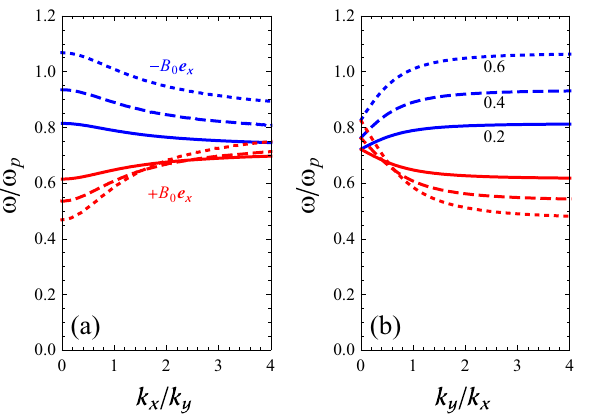
Figure 6. Dispersion curve of SMPs at a flat magnetized electron gas-vacuum interface, as obtained from Eq. (9), when ( a ) k y is positive constant and ( b ) k x is positive constant. Here the different curves correspond to ω c 0.2 ω p (solid lines), ω c 0.4 ω p (dashed lines), and ω c 0.6 ω p (dotted = = =